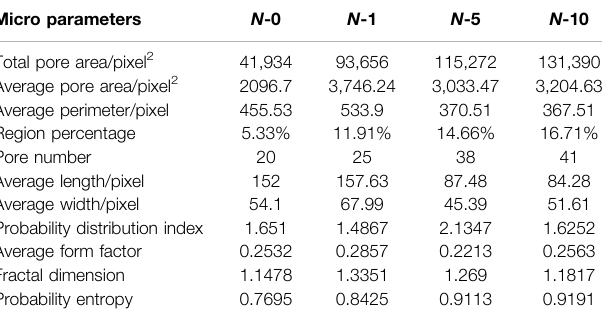
TABLE 3 | Statistical results of pore characteristics.